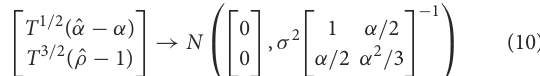
constraint is to eliminate the extreme conditions in the feasible solution